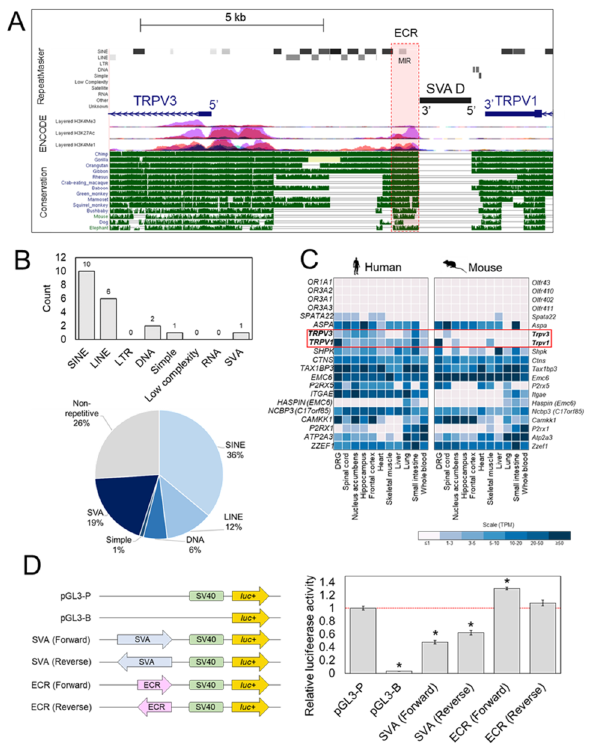
Figure 2. Intergenic region between TRPV1 and TRPV3 contains human-specific SVA insertion predicted to function as regulatory domain. ( A ) UCSC image of intergenic region between TRPV1 and TRPV3 . RepeatMasker displays repetitive DNA including SVA insertion (ECR containing MIR element is highlighted in red). ( B ) Analysis of TE composition of the intergenic sequence between TRPV1 and TRPV3 . ( C ) RNA-seq data showing normalized gene expression values (expressed as transcripts per million; TPM) of genes encoded at chr17p13.2 in human and orthologous genes encoded at chr11qB4-B5 in mouse. ( D ) Relative luciferase activity of pGL3-P reporter gene constructs with SVA (chr17:3466973–3468374) and ECR sequences (chr17:3466258–3466820) cloned upstream of the minimal SV40 promoter (green box) and transfected into HEK293 ( n = 4). * p -value <0.05 (2-sample t